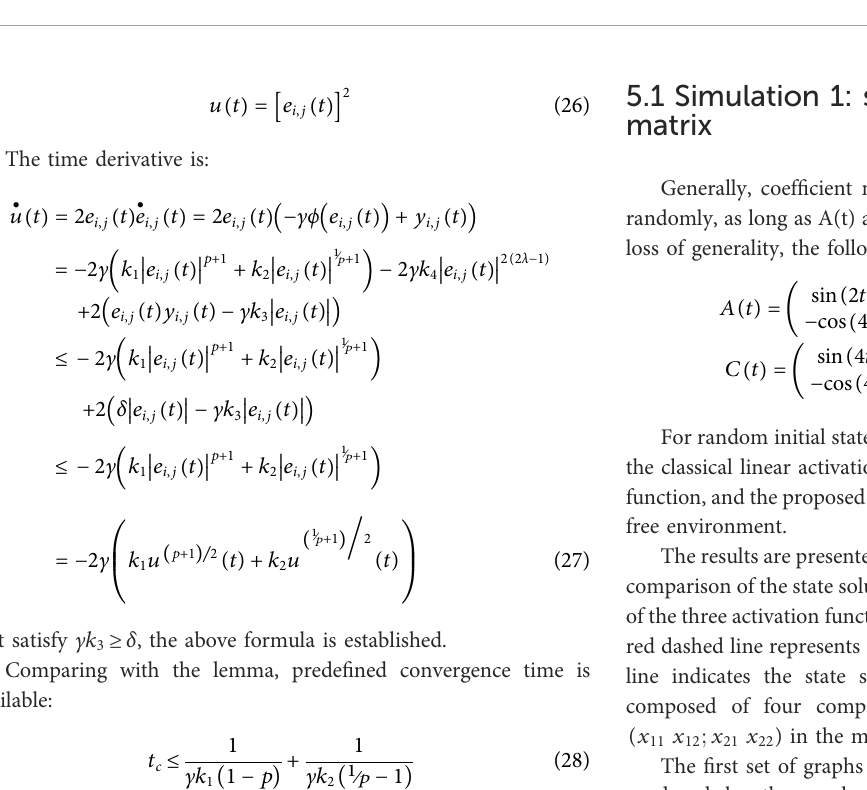
FIGURE 1 Thecomparisonofthestatesolutionandthetheoreticalsolution: (A) SSofNAFforsolvingSDSE; (B) SSofPSAFfor solvingSDSE; (C) SSofLAFforsolving